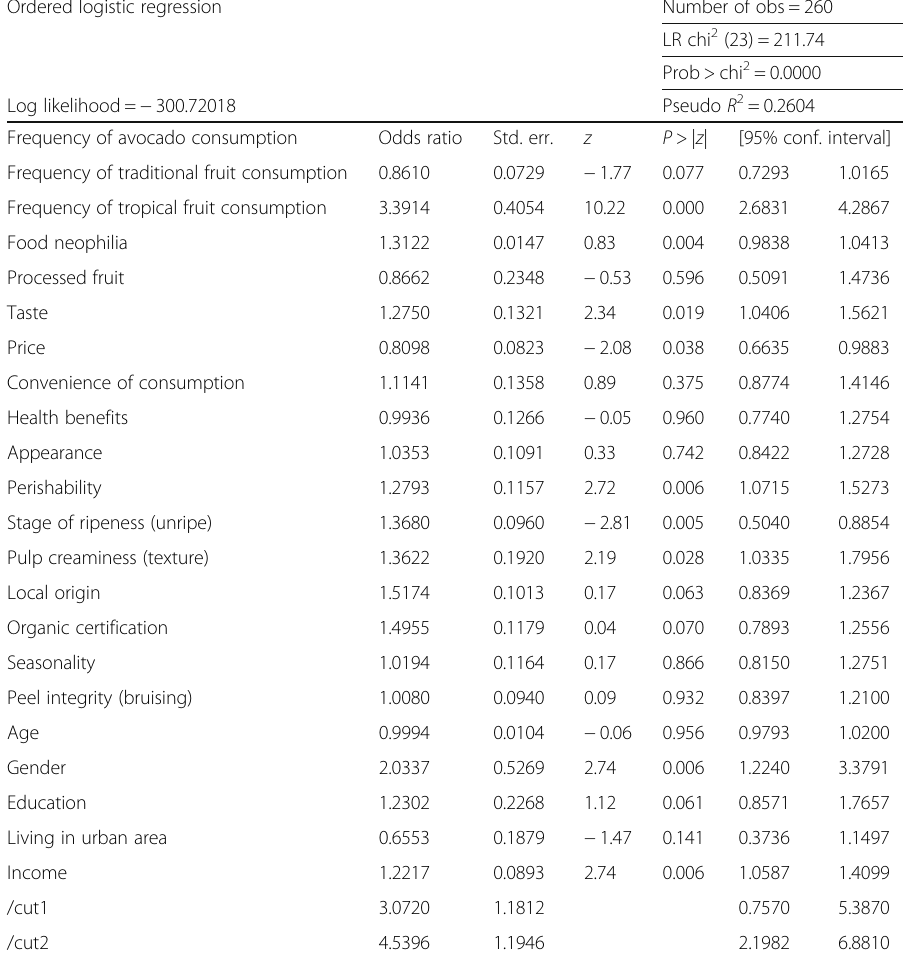
Table 5 Odds ratio calculated on the results of ordered logistic regression Ordered logistic regression Number of obs =